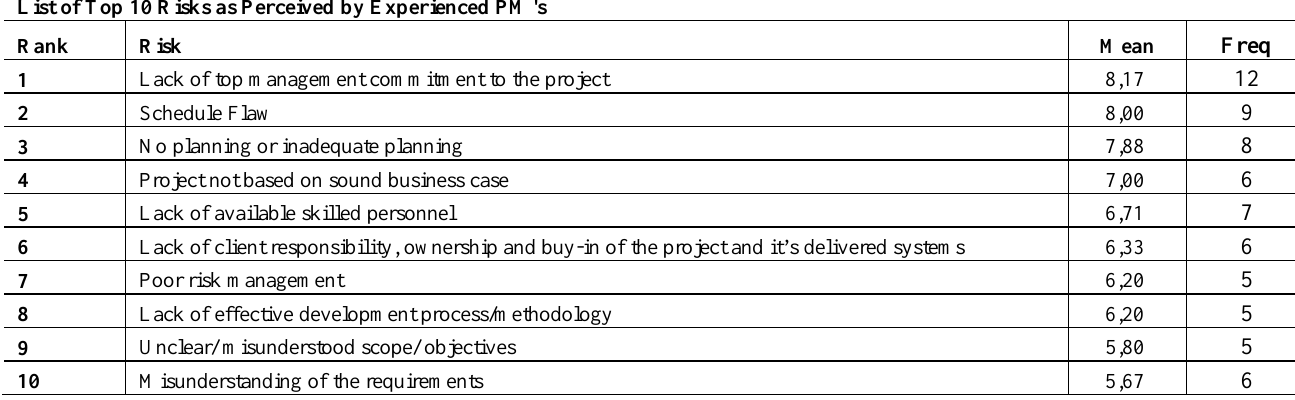
Table 3: Top Ten Risks as perceived by inexperienced PMs List of Top 10 Risks as Perceived by Inexperienced